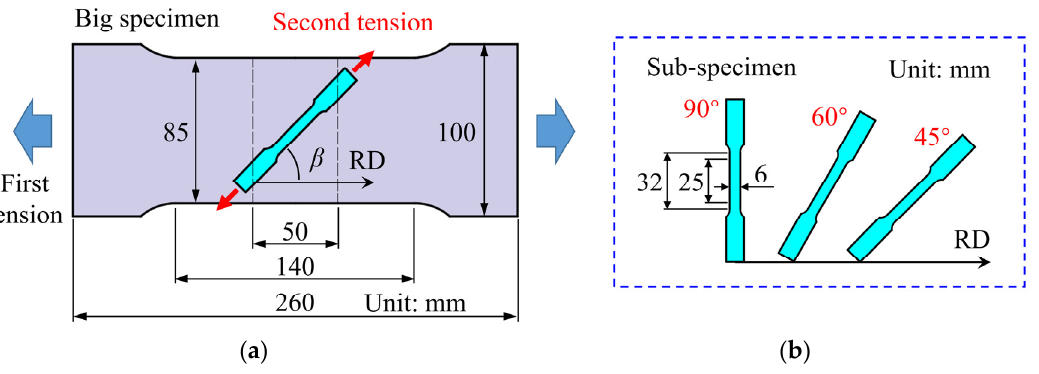
Figure 13. Stress–strain curves predicted by the HAH-2d model in two-step uniaxial tensions with tensile axes at 90° from each other.